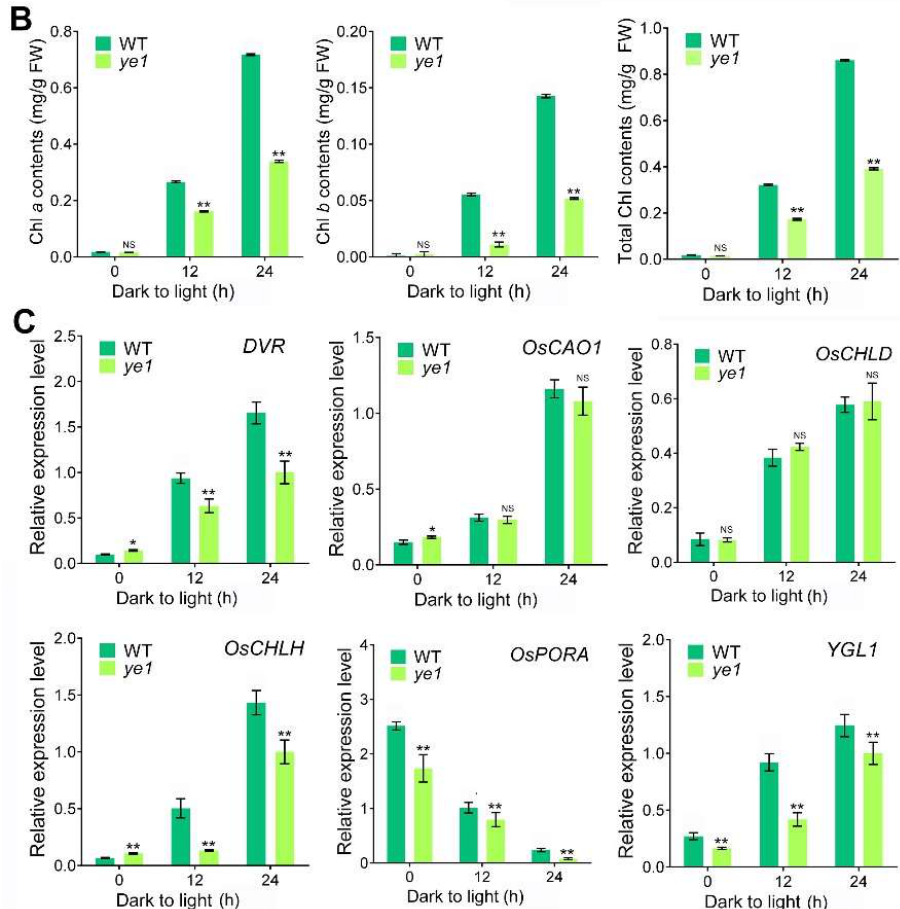
Figure 7. Expression levels of Chl synthesis-associated genes in WT and ye1 . ( A ) Comparisons of greening speed in WT and ye1 etiolated seedlings that were exposed to light for 12 or 24 h. Bar = 5 cm. ( B ) Comparisons of Chl contents in the WT and ye1 etiolated seedlings during light-induced greening. ( C ) Comparisons of changes in expression levels of Chl synthesis-associated genes in WT and ye1 etiolated seedlings during light-induced greening. Each value is given as means ± SD or SEM ( n = 3). NS, no significant change. * ( p < 0.05) and ** ( p < 0.01) indicate significant differences compared with WT (Student’s t -test).